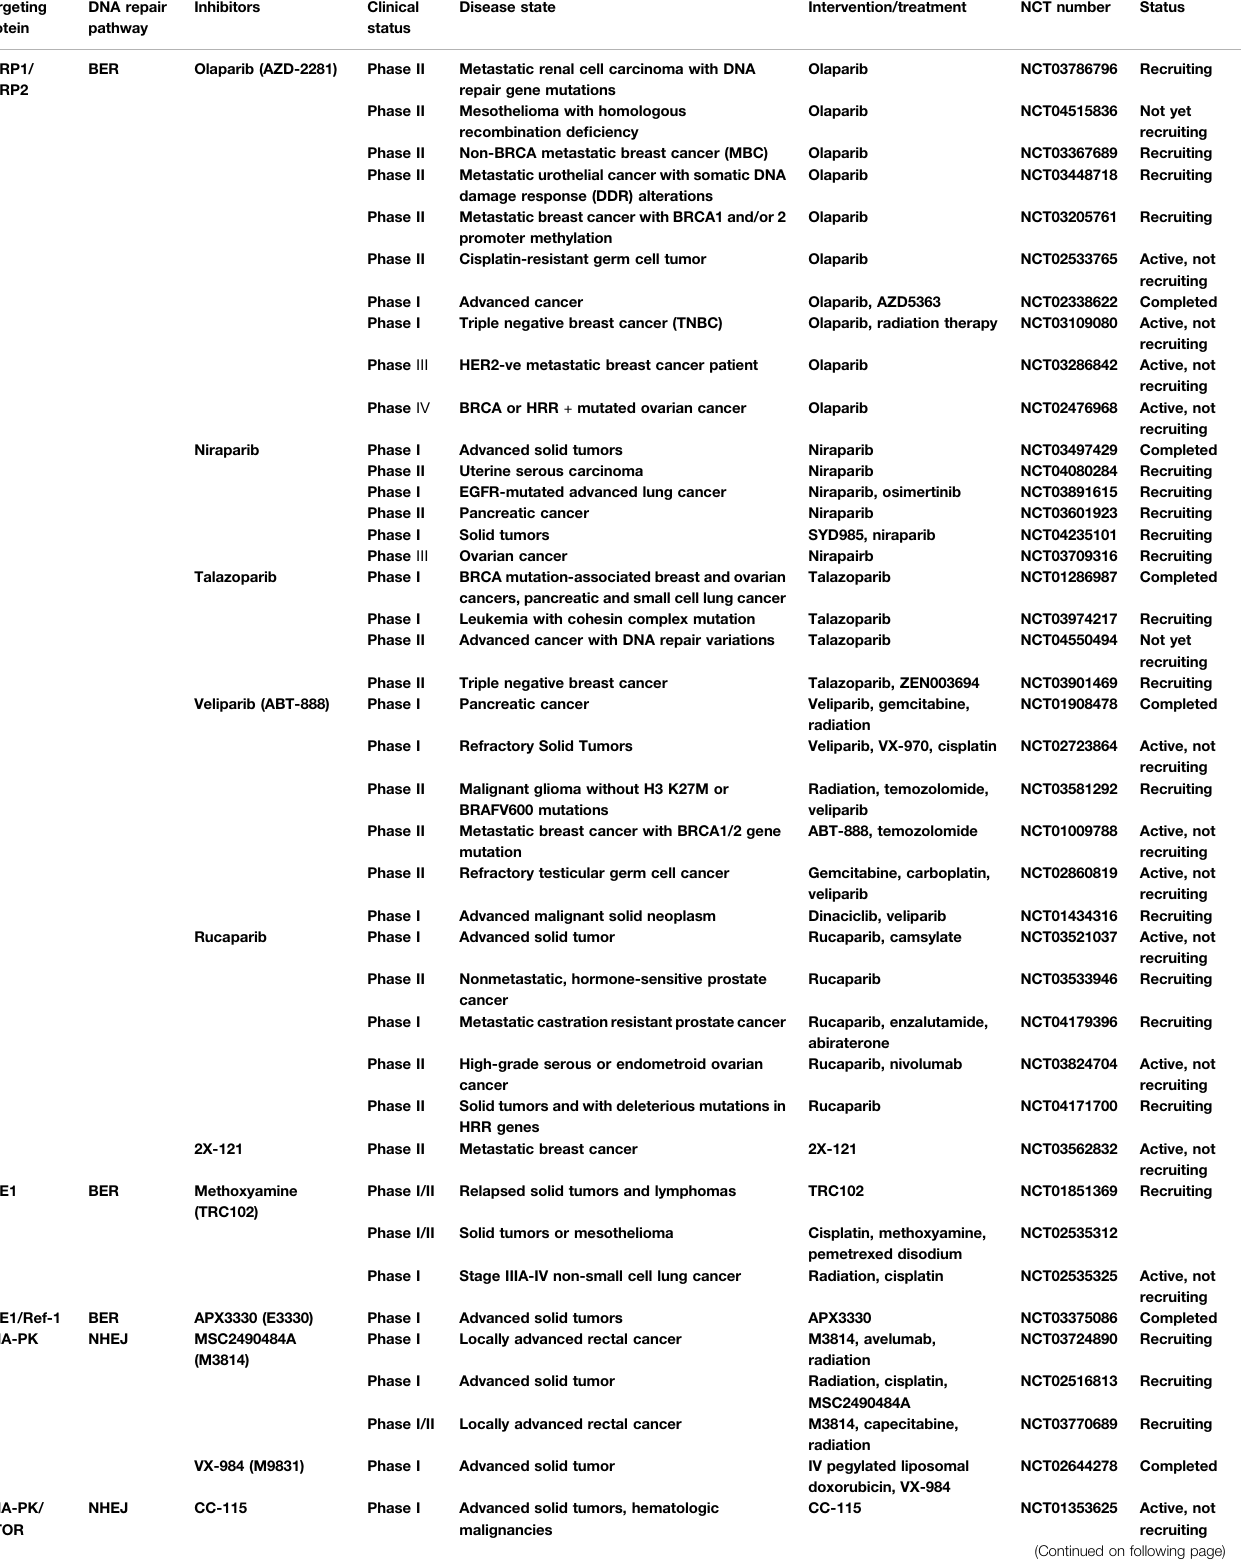
TABLE 1 | DNA repair pathway inhibitors in current clinical trials. Targeting